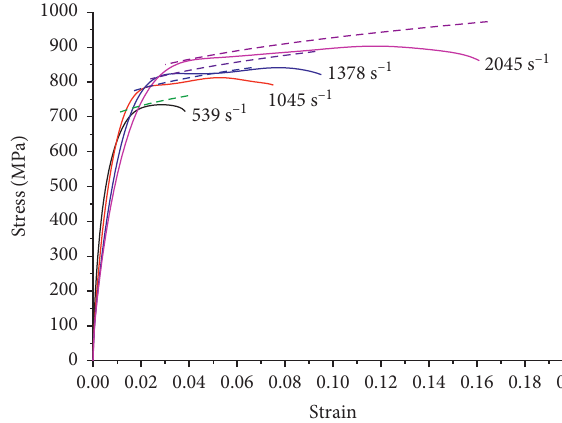
Figure 6: Comparison of Johnson–Cook model and experimental curve under different strain rates.